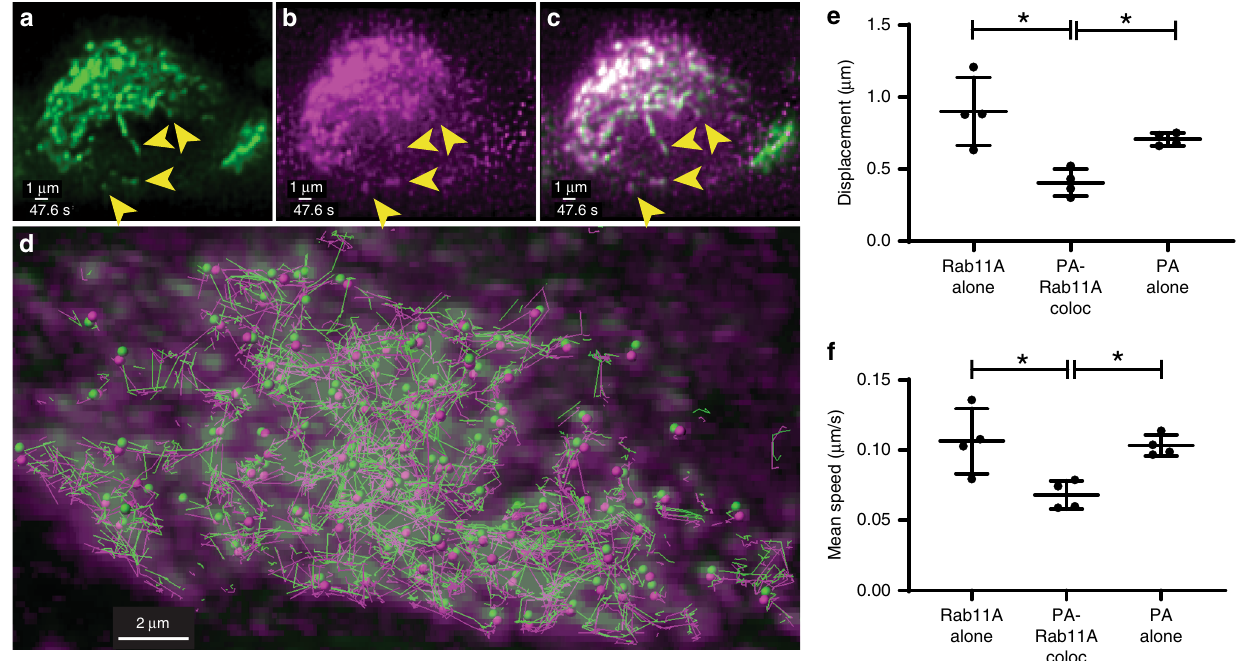
Fig. 6 Two-color imaging of PA::mRuby-infected GFP-Rab11A cells. A549 cells stably expressing GFP-tagged Rab11A were infected with recombinant mRuby-tagged PA expressing IAV A/WSN/33. Cross-section through the volume depicting the signal from a GFP-Rab11A, b mRuby::PA, and c merged channels. Note the absence of GFP-Rab11A signal from the nuclear volume, whereas PA::mRuby comprises a homogeneous signal from within the nucleus. Yellow arrowheads point out the corresponding colocalizing puncta in the three channels corresponding to co-transporting species (see Supplementary Movie 11). d Overlap between maximum projection of GFP-Rab11A (green) and PA::mRuby (magenta) channels at a single timepoint (0 s) for the same dataset. Colocalizing puncta from each species at that timepoint are depicted by spheres of corresponding colors, while lines of corresponding colors depict their tracks over all times. Signi fi cant co-travel between colocalizing puncta is observed on account of close proximity between individual track segments traveling along the same direction. In the right panels, each datapoint represents an individual cell ( n = 4 cells) using CF 50 for the corresponding motion parameters: e track displacement and f, track mean speed for Rab11A singletons, Rab11A colocalized with PA::mRuby and PA::mRuby singletons. Mean± SD are shown per group (* implies p < 0.05, comparisons performed using one-way ANOVA with Tukey ’ s multiple tests). Source data are provided as a Source Data fi